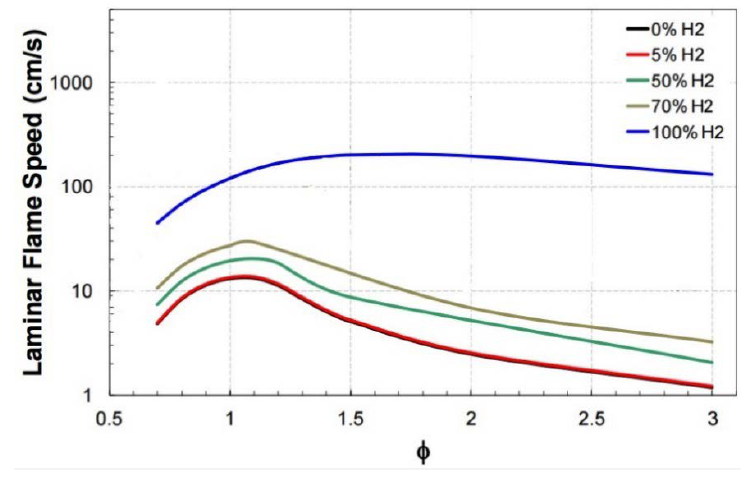
Figure 20. Effect of blending hydrogen in natural gas on the laminar flame speed at 15 kPa and 300 K, extracted from Reference [218].